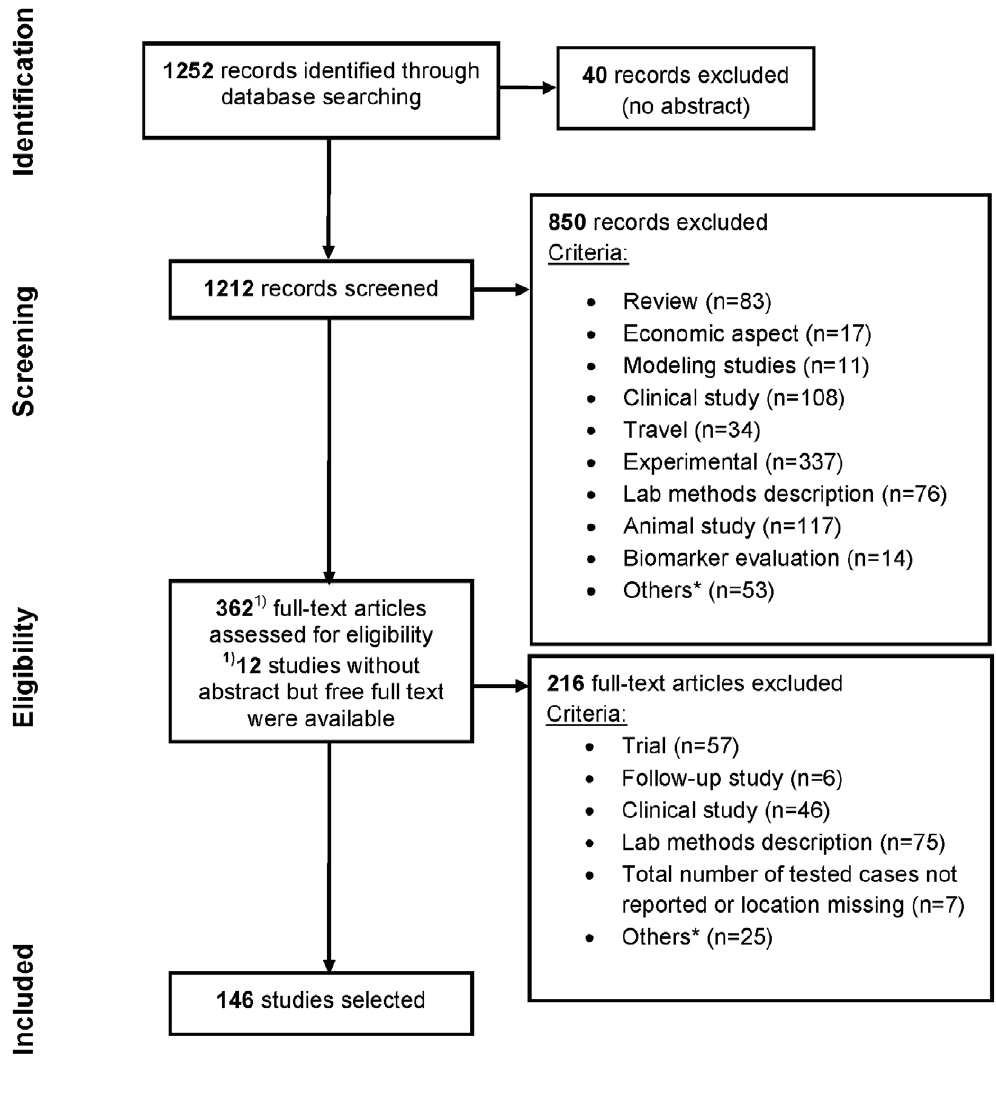
Figure 1. PRISMA flow chart for literature search.